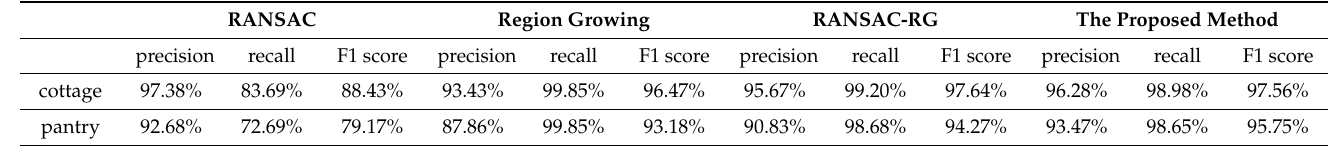
Table 6. Assessment of segmentation results for